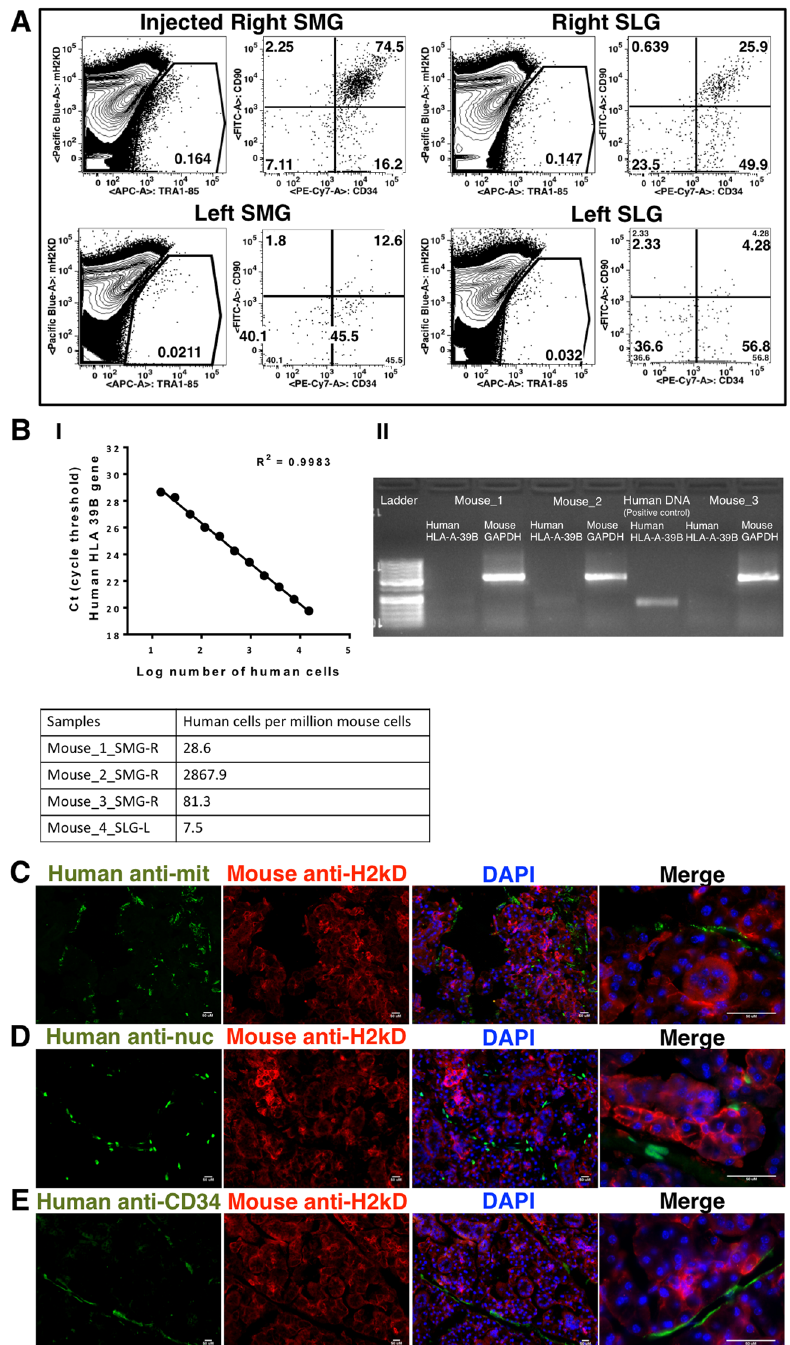
Figure 8. In vivo engraftment and functional characterization of PAG, SLG and SMG derived MSCs in NSG mice ( A ) engraftment and migration of injected human cells in paired mice SMGs and SLGs. Human cells were stained with pan human TRA1-85 (CD147) antibody. Mouse cells were detected by mouse specific H-2K d staining. ( B ) Detection and quantification of human cell engraftment by quantitative real-time PCR. ( C ) Immunohistochemical detection of engrafted human cells using pan human marker, human anti-mitochondrial antibody (green) and mouse H-2K d (red) in SMG of mice. ( D ) Immunohistochemical detection of engrafted human cells using pan human marker, human anti-nuclei antibody (green) and mouse H-2K d (red) in SLG of mice. ( E ) Analysis of expression of human CD34 (green) on engrafted human cells in mice SMG using mouse H-2K d (red). Nuclei was stained with DAPI (blue). All scale bars represent 50 µ